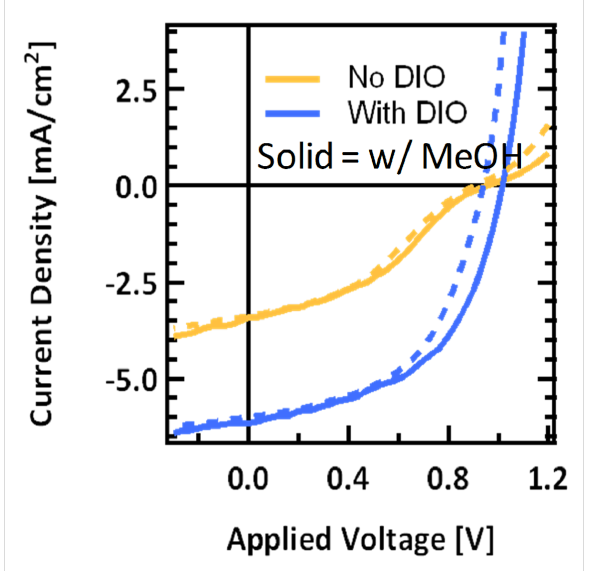
Figure 4: Current voltage curves for devices cast from pure chloroben- zene (yellow) and with 1.5% DIO (blue) with (solid) and without (dashed) methanol